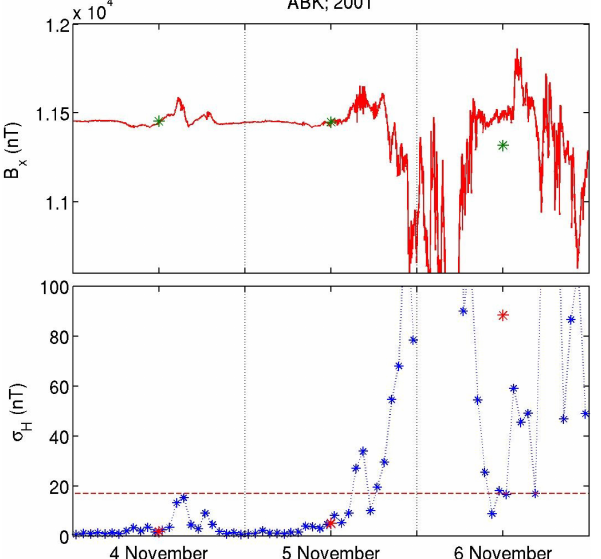
Fig. 5. Top panel: B x in Abisko on 4–6 November 2001, and the daily median values calculated from it (green stars). Bottom panel: hourly standard deviations σ H of these data (blue stars), daily me- dians σ H of these (red stars), and suggested threshold value for med σ H of B x in Abisko (red dashed line). med